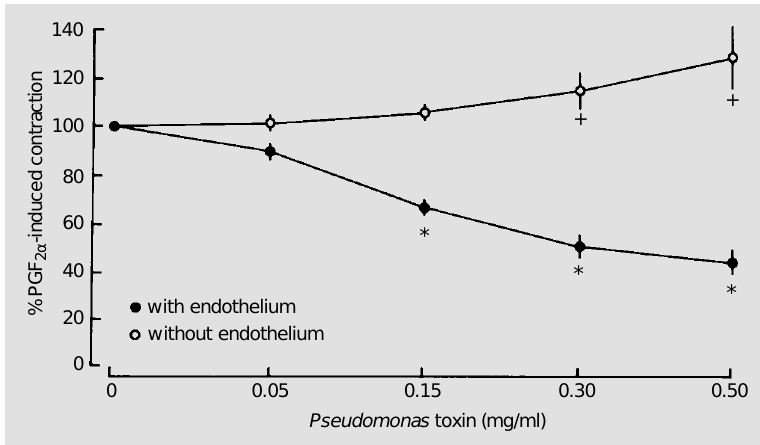
Figure 4 - Concentration-response relationship for Pseudomonas aeruginosa lipopolysac- charide in canine renal arteries (N = 6). Segments were contracted with 2 µM prostaglandin F 2 a (PGF 2 a ) (initial tension) and exposed to increasing concentrations of endotoxin (0.05- 0.50 mg/ml). Results are reported as means ± SEM. *P<0.05 compared to the initial tension of arterial segments with endothelium (Student t -test). + P<0.05 compared to initial tension of arterial segments without endothelium (Student t